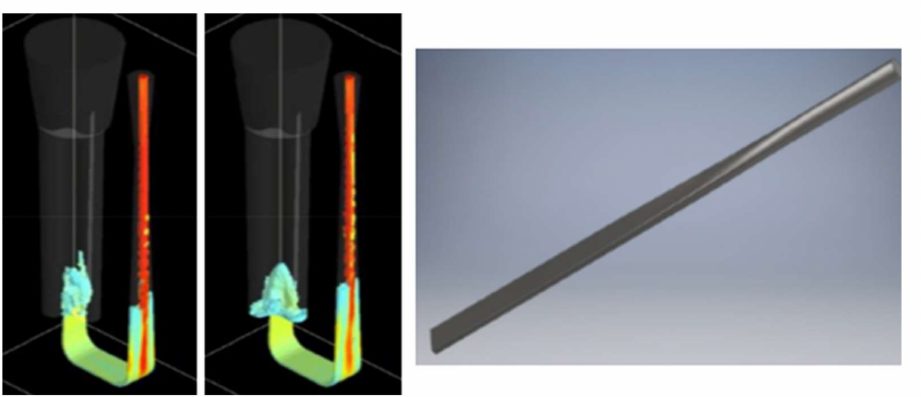
Figure 14. Improper tapering of the transitional sprue ( left ); 3D model of the properly tapered sprue used in initial studies ( right